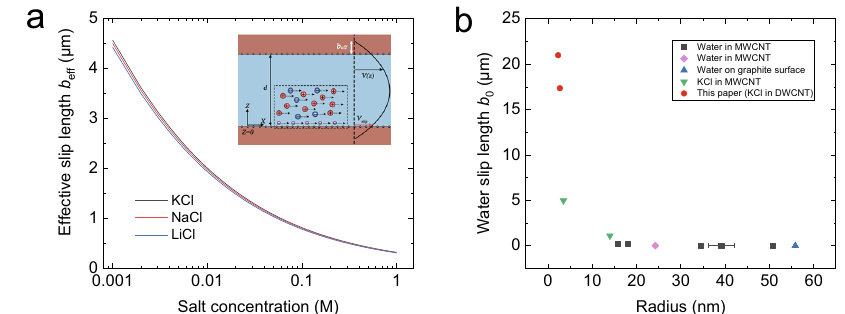
b respectively. b Water slip length b 0 = lim eff in carbon nanotube as a function of C s ! 0 innertuberadius.Theblack,purple,blue,andgreensymbolsareexperimentaldata from existing measurements 1,13,42,49 . Source data of this fi gure are provided as a Source Data fi